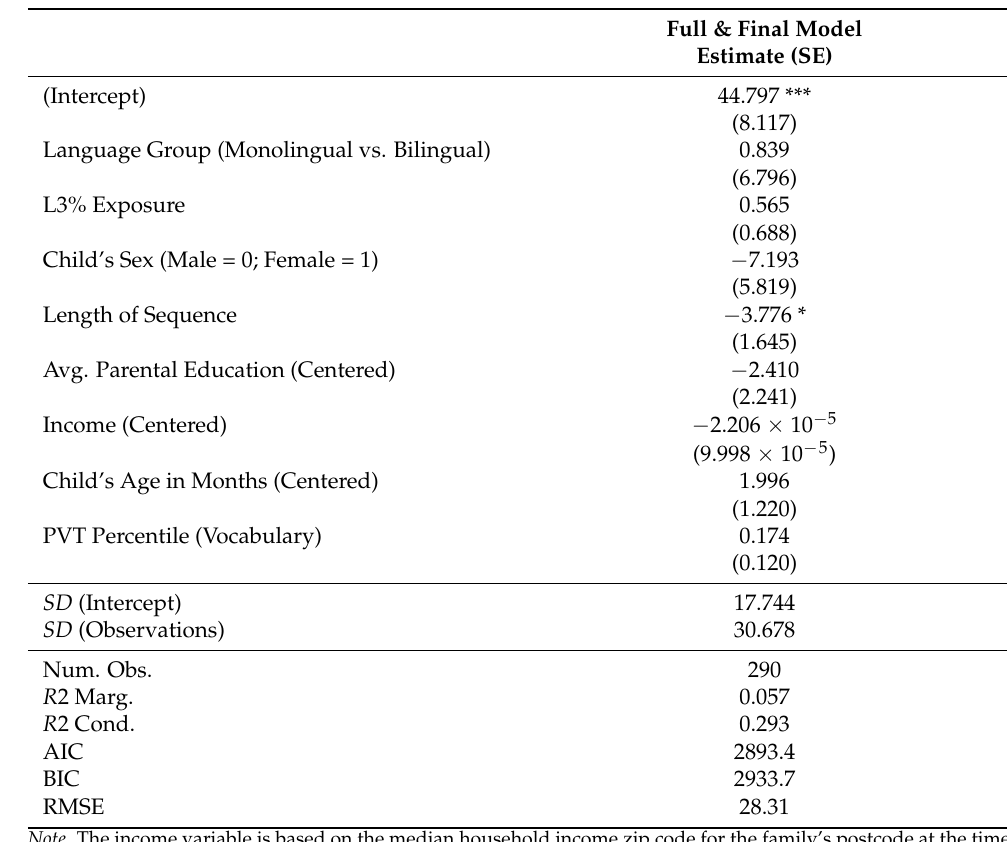
Table 6. Mixed Effects Models for Analysis Approach 2-Binary Language Classification.